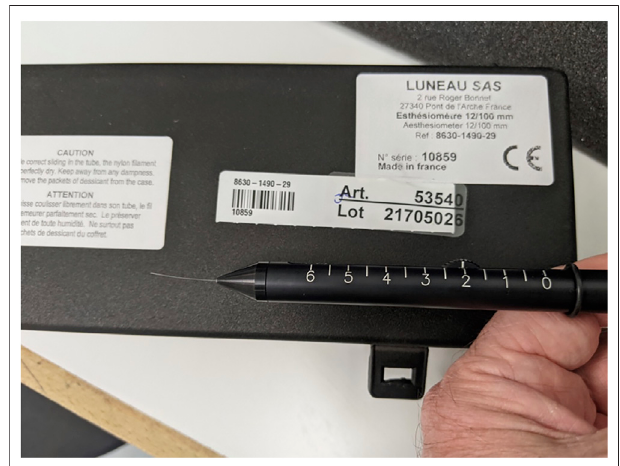
FIGURE 2 | Cochet-Bonnet